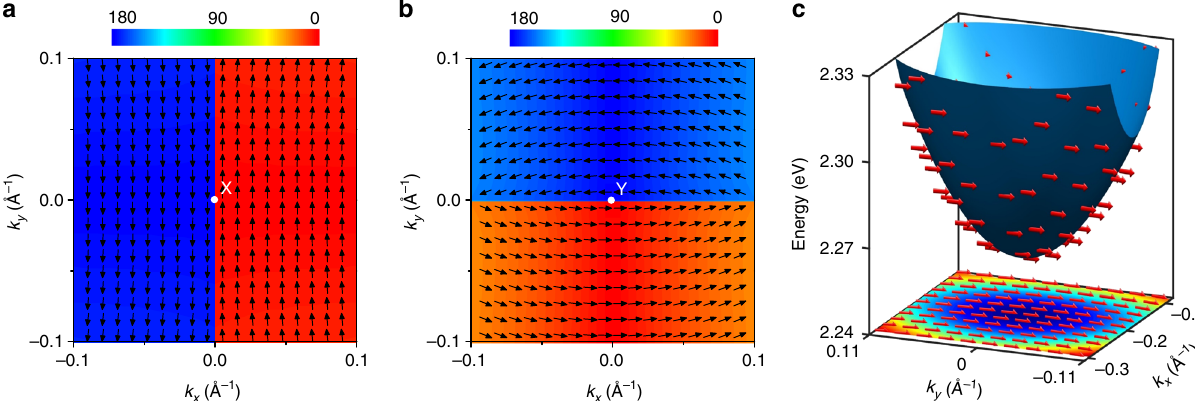
Fig. 5 Spin texture of BiInO 3 . a, b Spin con fi gurations around the high-symmetry k points: X point a and Y point b . The spin textures are plotted in the k z = 0 plane for the lowest energy conduction bands. The wave vector k is referenced to the X point ( a ) and Y point ( b ), where it is assumed to be zero. The color map re fl ects the polar angle (in degrees) with respect to the y -axis ( a ) and x -axis ( b ). c 3D diagram and 2D projection of band structure and spin texture around the CBM. The arrows indicate the spin direction. The color map shows the energy pro fi le. The wave vector is referenced to the X point where is it assumed to be